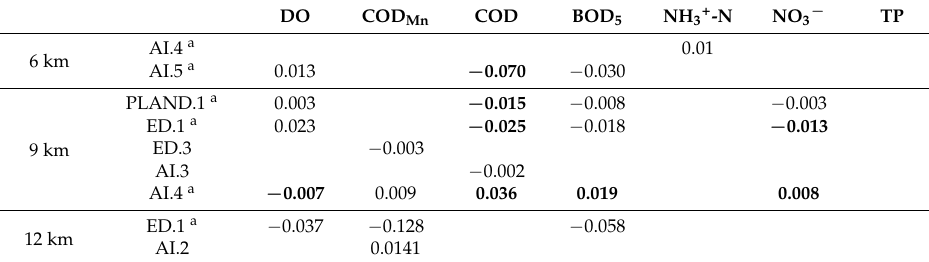
Table 4. Summary of the PLSR models for specific water contaminants during the wet season. DO COD Mn COD BOD 5 NH 3+ -N NO 3 −